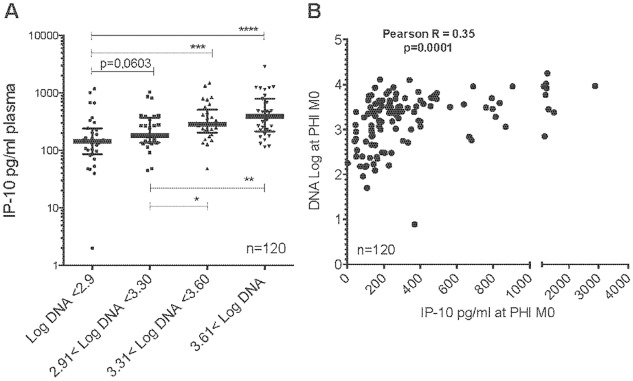
Relationship between plasma IP-10 levels and cell-associated DNA levels during primary HIV-1 infection.
A. IP-10 plasma concentrations stratified on cell-associated DNA levels during PHI (M0). B. Correlation between IP-10 concentrations and cell-associated DNA levels during PHI (M0). M0 = primary HIV-1 infection and time of inclusion (Fiebig stage III/IV).